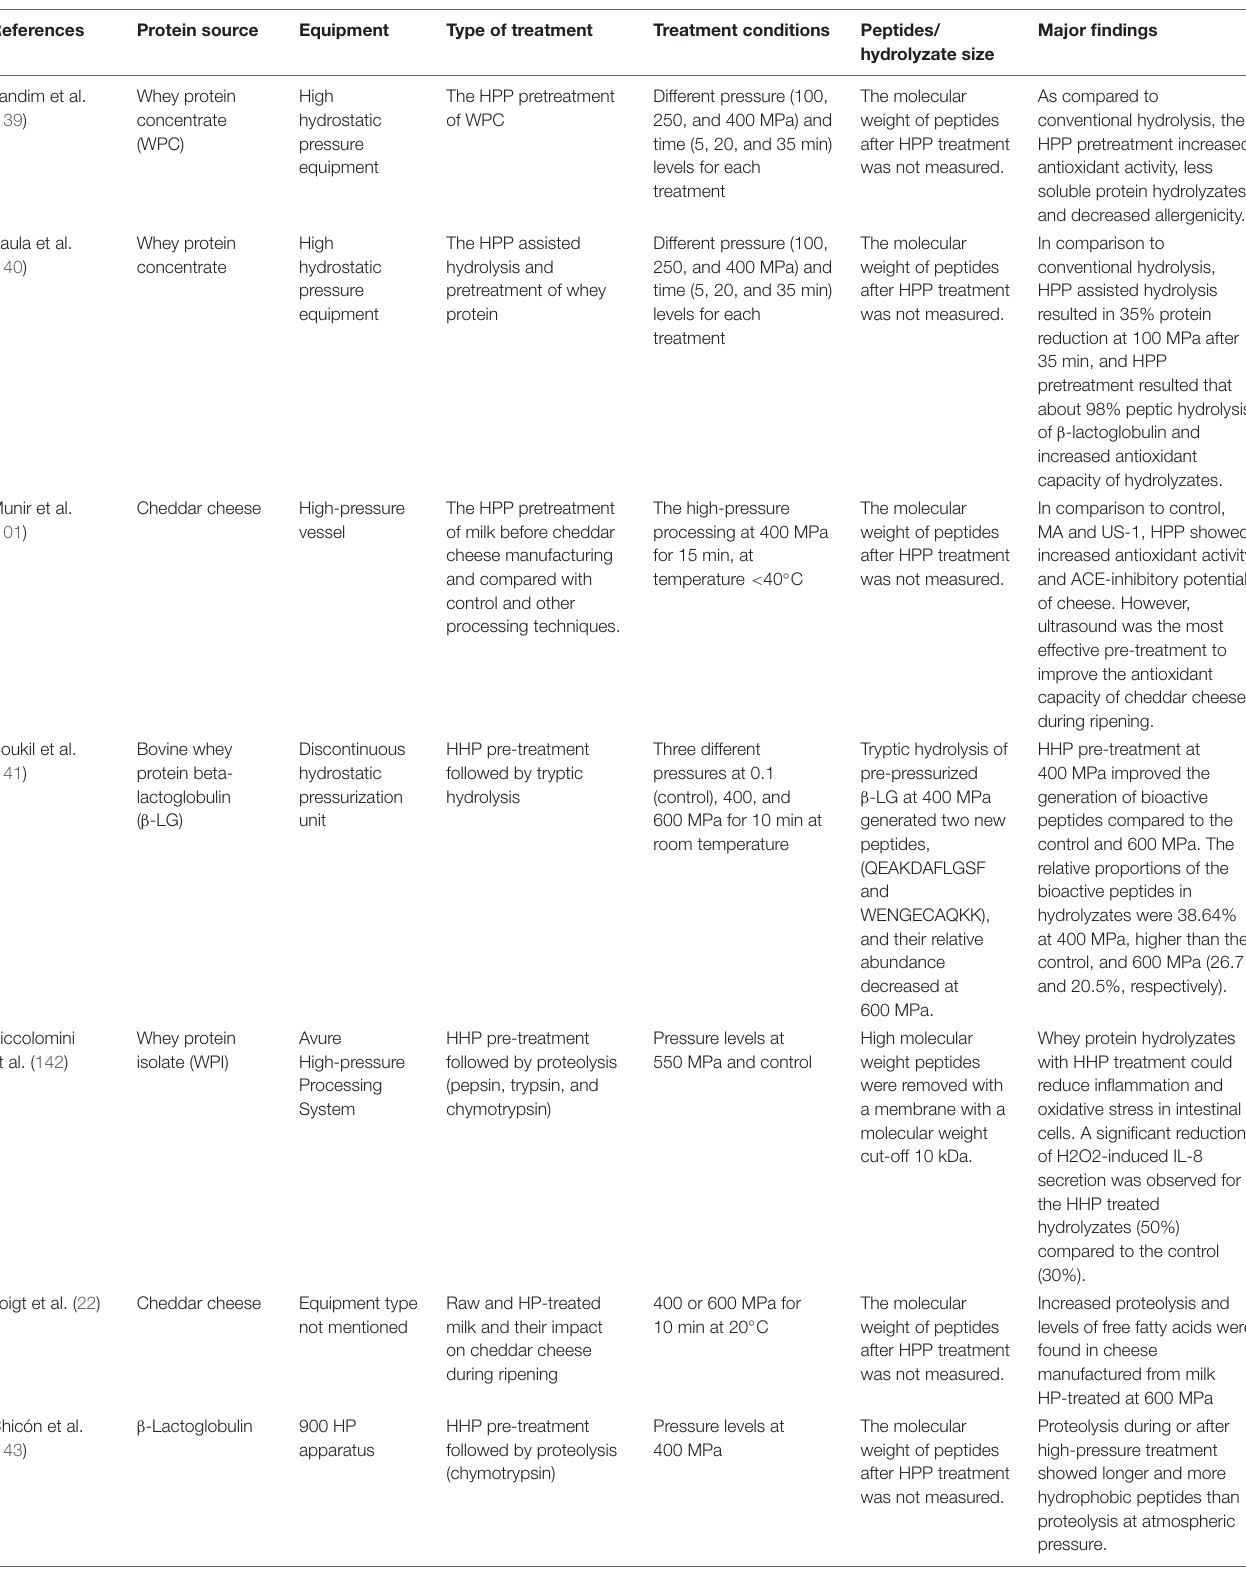
TABLE 5 | Applications of high-pressure processing for the production of bioactive